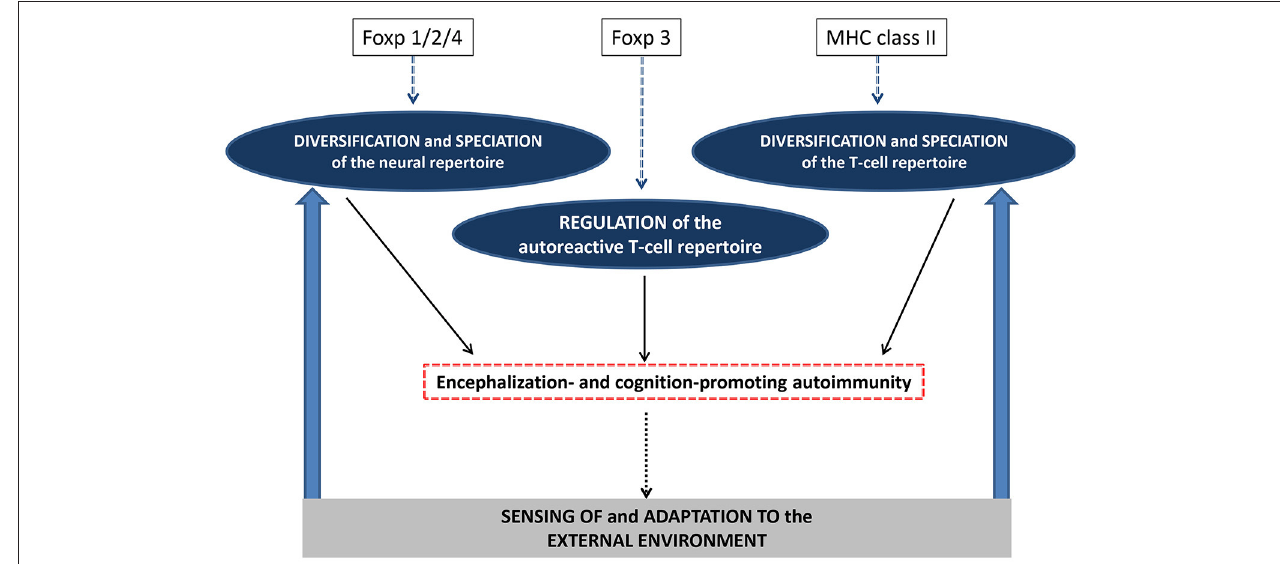
FIGURE 5 | Autoimmunity and the evolutionary genetics of encephalization and cognition. It is suggested that evolution of the Foxp1/2/4 genes have not only contributed to a diversification of neural repertoire but have instructed what could be called a “speciation” of such repertoire i.e., the acquisition of species-specific features. In parallel, evolution of the MHC class II genes have contributed to the diversification and “speciation” of the T-cell repertoire, notably the autoreactive T-cell repertoire directed against brain superautoantigens. Finally, evolution of the Foxp3 gene may have allowed a species-specific control of cognition-promoting autoimmunity. These combined mechanisms would support an endogenously-driven and species-specific processes which would shape encephalization and cognition. By this mean, external cues exerting a selection pressure on a given species would be filtered by the internally-fueled sensing skills of this species. In turn, perceived externals cues would further instruct the diversification and speciation of the neural and T-cell